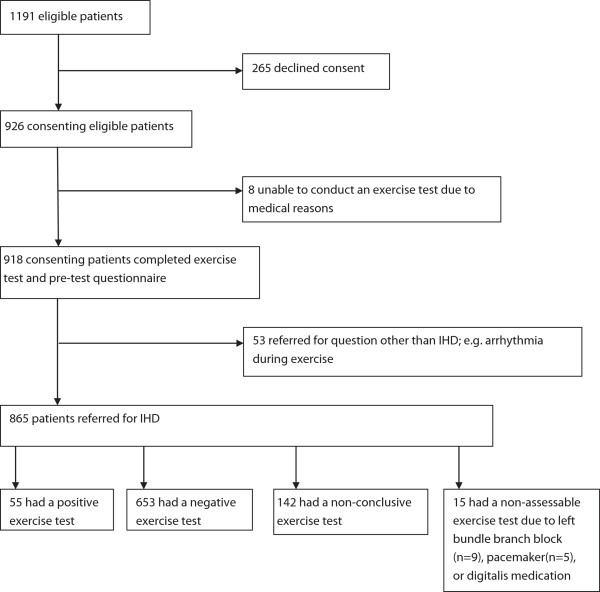
Study profile of participant recruitment and outcomes according to classification of exercise tests.